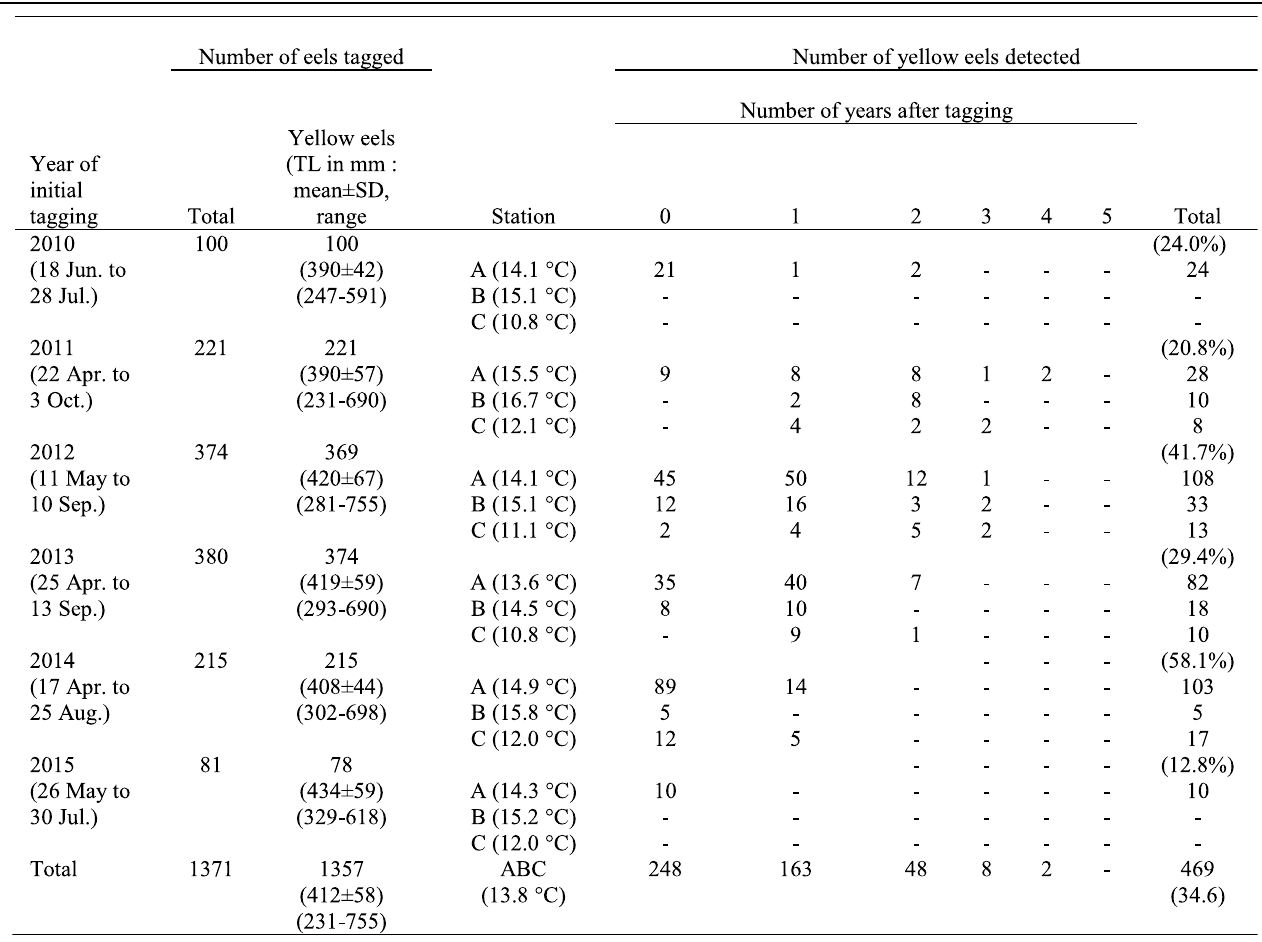
Table 3. Number of eels detected each year according to the date of initial tagging. TL is the total length of yellow eels; C indicates the mean daily water temperature of the full year; range dates in brackets show the time window of tagging and release of the eels; and A , B and C correspond to the detection stations on the Meuse River ( A , B ) and the Ourthe tributary ( C ); total percentage in brackets is the proportion (%) between the total number of eels detected over the years at all stations and the total number of eels tagged for each initial tagging